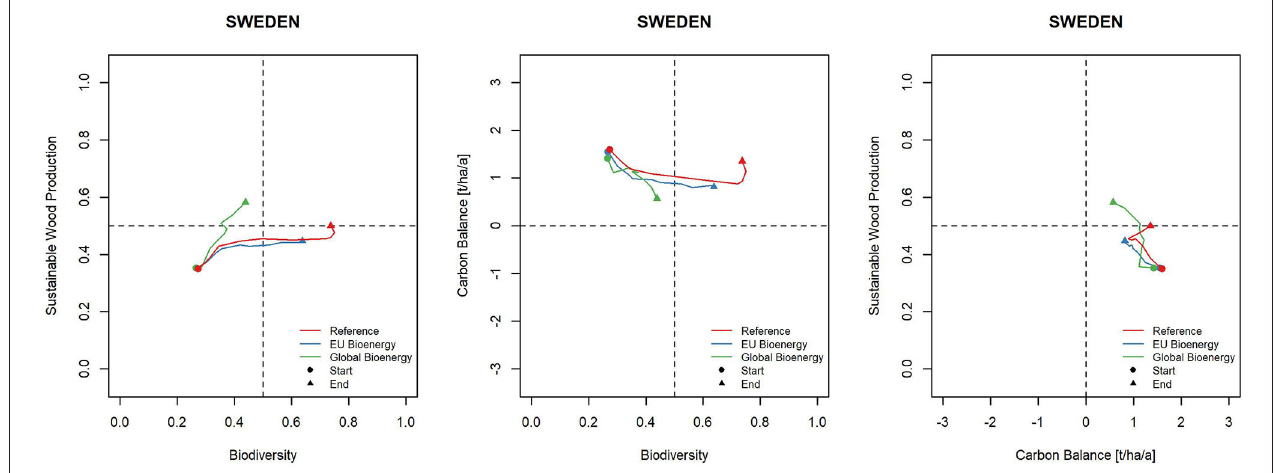
FIGURE 2 | Trade-off diagrams for